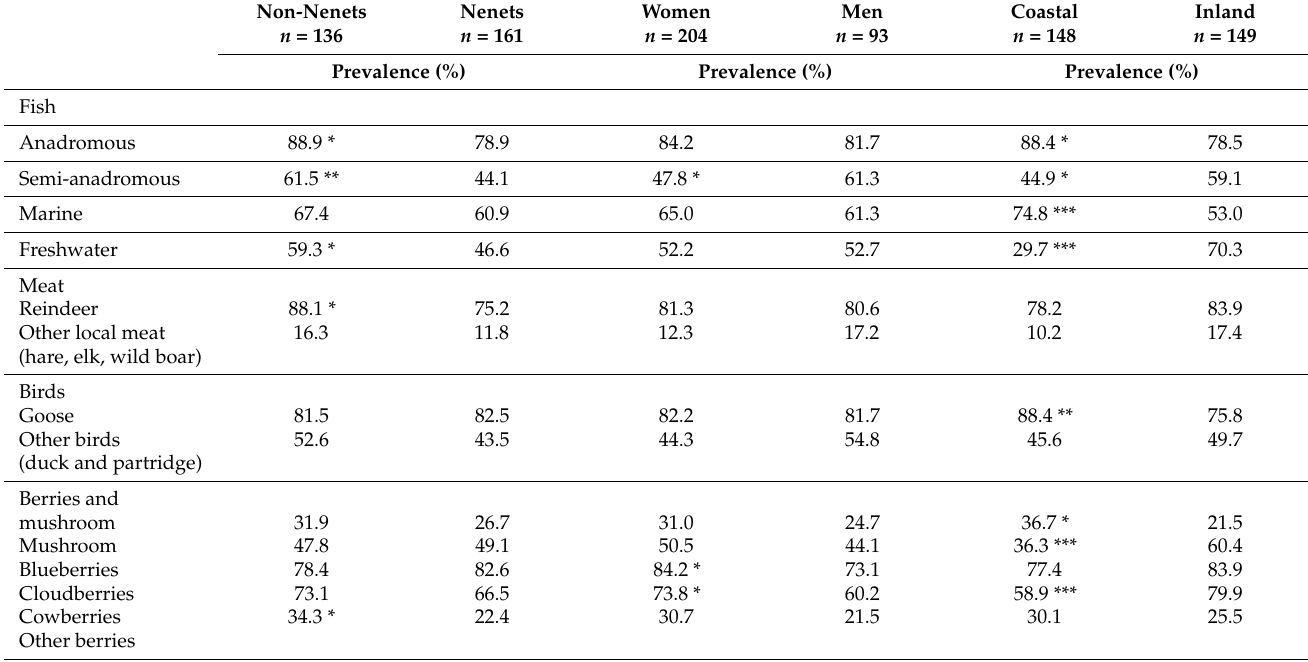
Table 1. The prevalence (in %) of subjects consuming local food items among female and male Nenets and non-Nenets inhabitants during a one-month